Question: Condense the content of this figure into a single sentence.
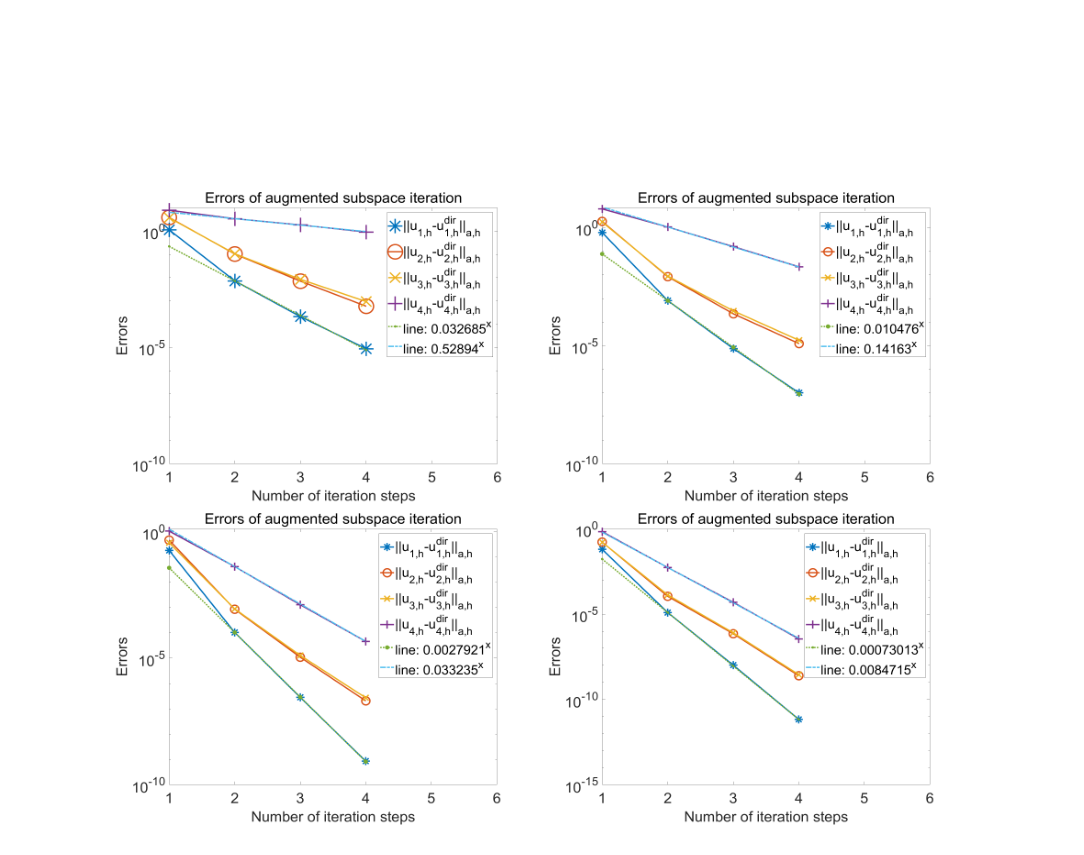
Answer: The convergence behaviors for the smallest 4 eigenfunctions by Algorithm 1 with the coarse space being the linear finite element space on the mesh with size H = √